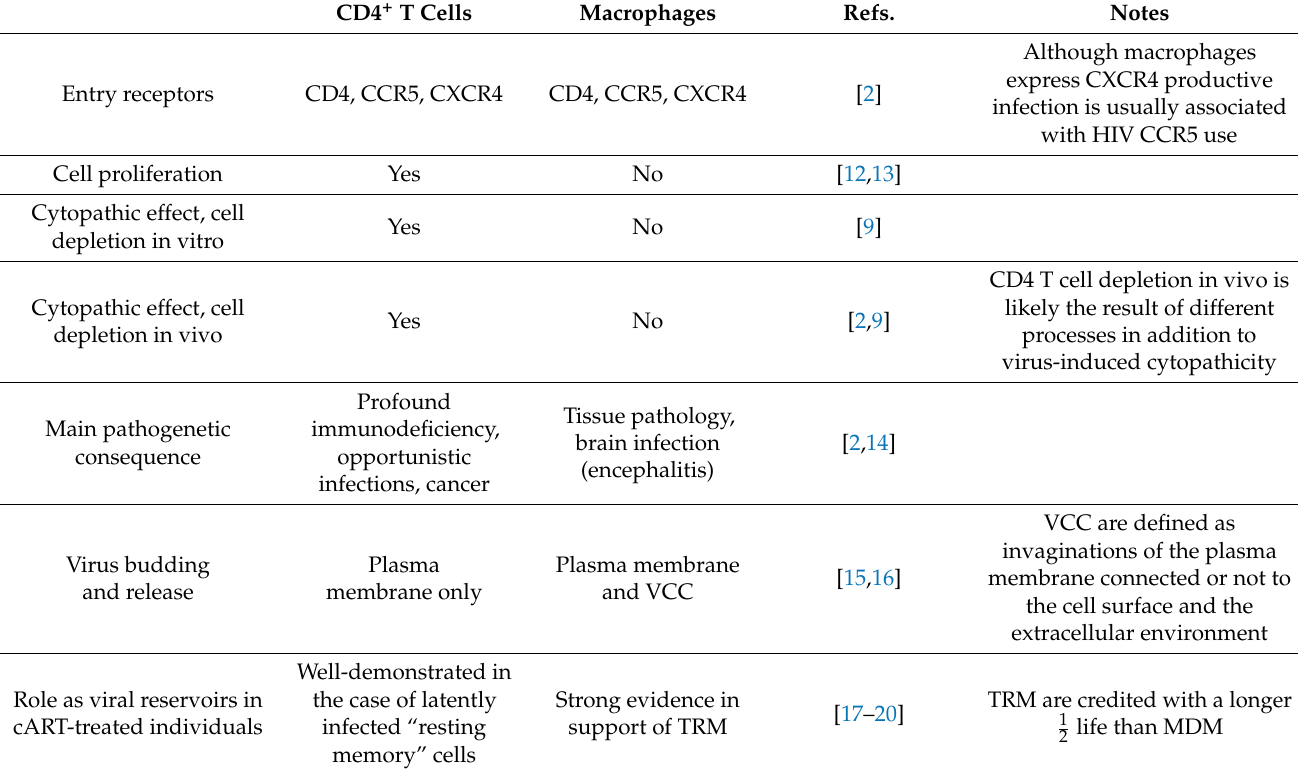
Table 1. Similarities and differences between CD4 + T cell and MDM infection in vitro and in vivo. CD4 + T Cells Macrophages